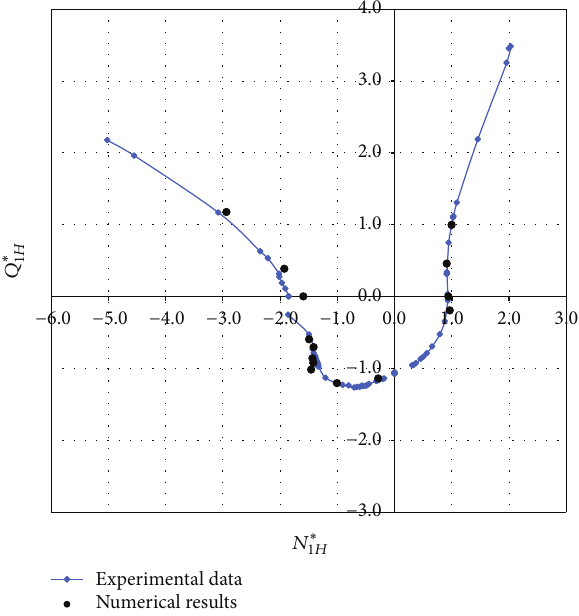
Figure 10: Comparisons between experimental data and numerical results obtained from unsteady